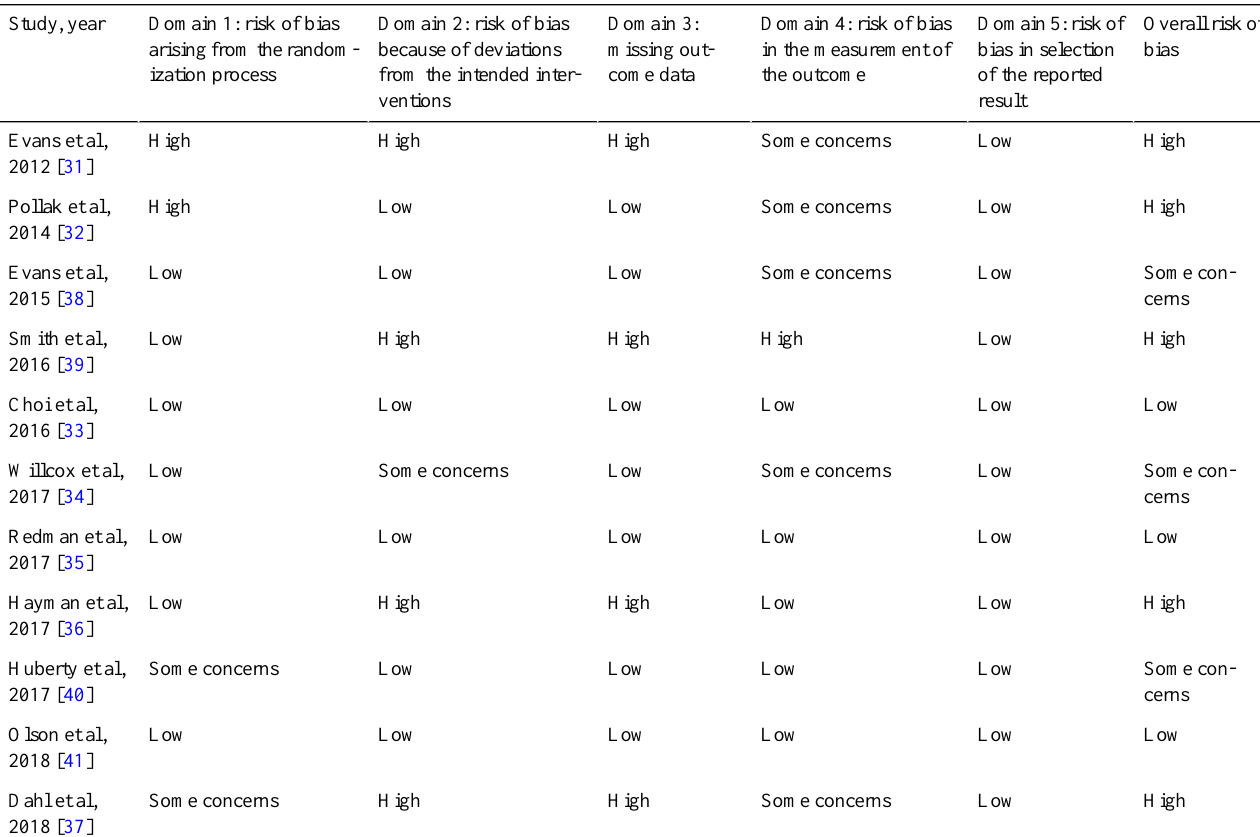
Table 2. Risk of bias summary.